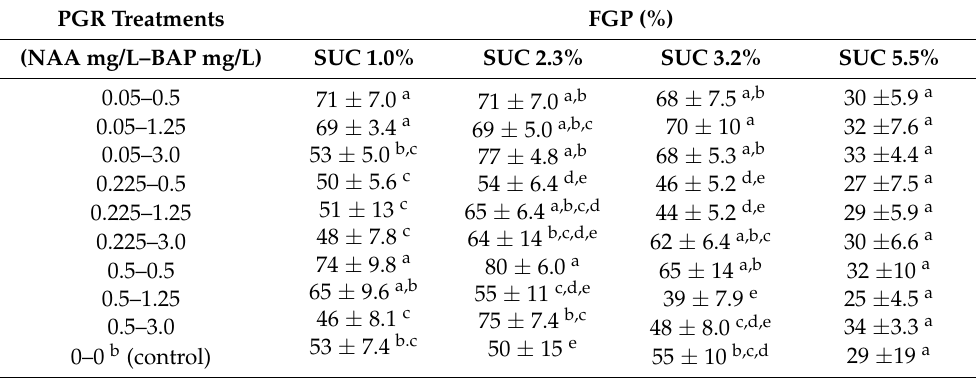
Table 3. FGP of Taraxacum officinale seeds at different concentration of sucrose (SUC) and PGRs treatments. Medium supplemented with NAA and BAP (in combinations) at 18 ◦ C and photoperiod 18/6 h